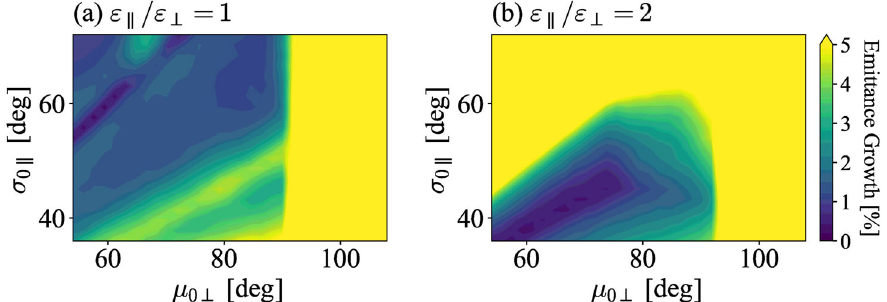
FIG. 11. W ARP simulation results obtained with the initial emittance ratios (a) ε k = ε ⊥ ¼ 1 and (b) ε k = ε ⊥ ¼ 2 . The simulation conditions are the same as in Fig. 10 except for the value of ε k = ε ⊥ in the right panel.